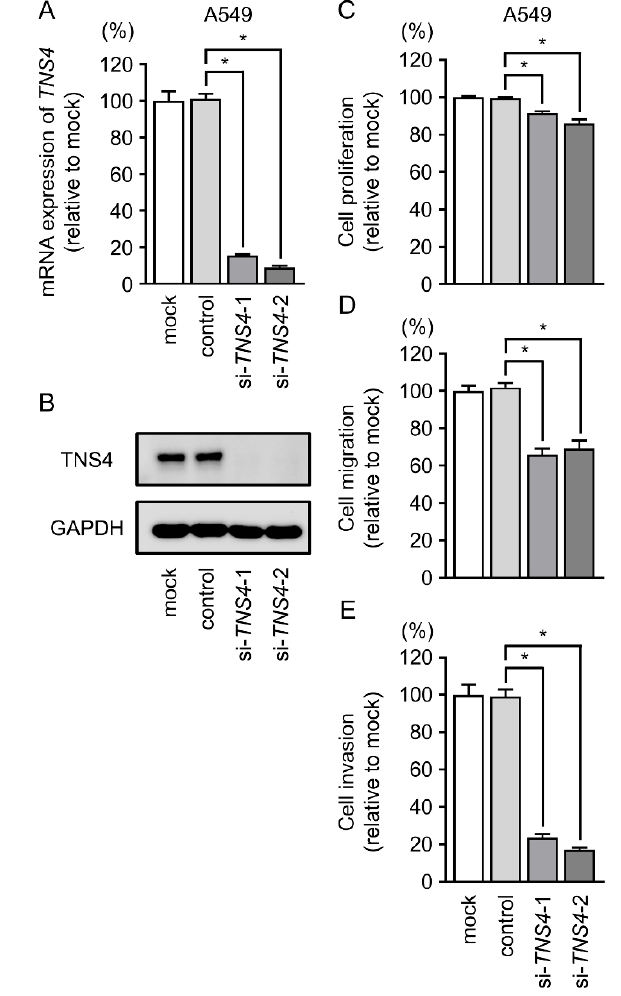
Figure 6. Knockdown studies of TNS4 /TNS4 using si- TNS4 in LUAD cells (A549 and H1299). ( A , B ) TNS4 mRNA and protein expression 48 h after transfection of si- TNS4 -1 or si- TNS4 -2 in LUAD cell lines. ( C – E ) Cell proliferation, migration, and invasive activities were significantly blocked by si- TNS4 transfection into LUAD cell lines. * p < 0.01.